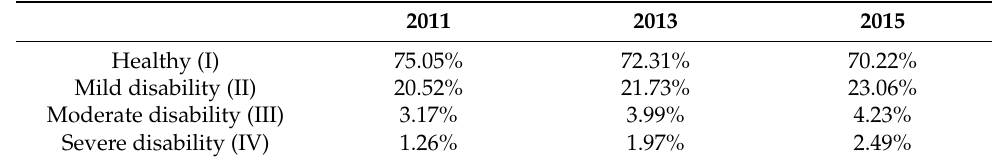
Table 2. Disability rate among the Chinese aged 60 and above,